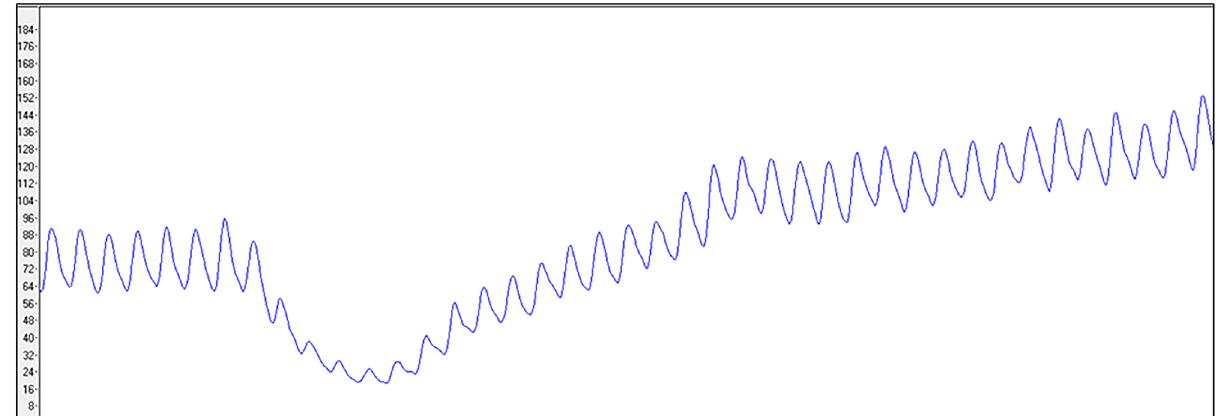
Figure 2. An example of graph which illustrates an actual form of intraoperative blood flow monitoring on the sole of a patient using laser doppler flowmetry during endoscopic lumbar sympathectomy. Peripheral blood flow abruptly decreased right after electro-cauterization of the lumbar sympathetic chain, increased gradually during the sympathectomy, and remained a higher level compared to that before the